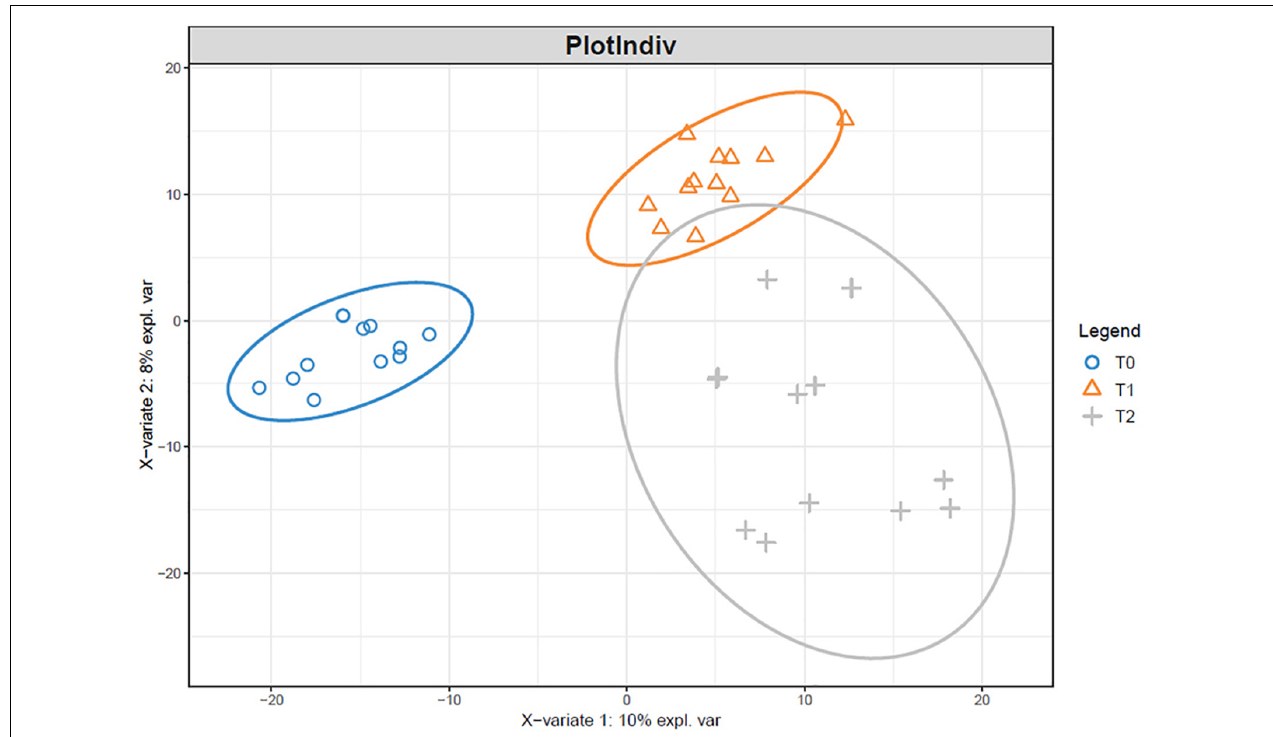
FIGURE 6 | Partial least squares discriminant analysis of the microbial communities in the tailing sand at the OTU level. T0, iron tailing sand + soil; T1, iron tailing sand + soil + Pennisetum giganteum ; T2, iron tailing sand + soil + bio-matrix pot + Pennisetum giganteum . TABLE 3 | Differentially abundant OTUs in the iron tailing sands.